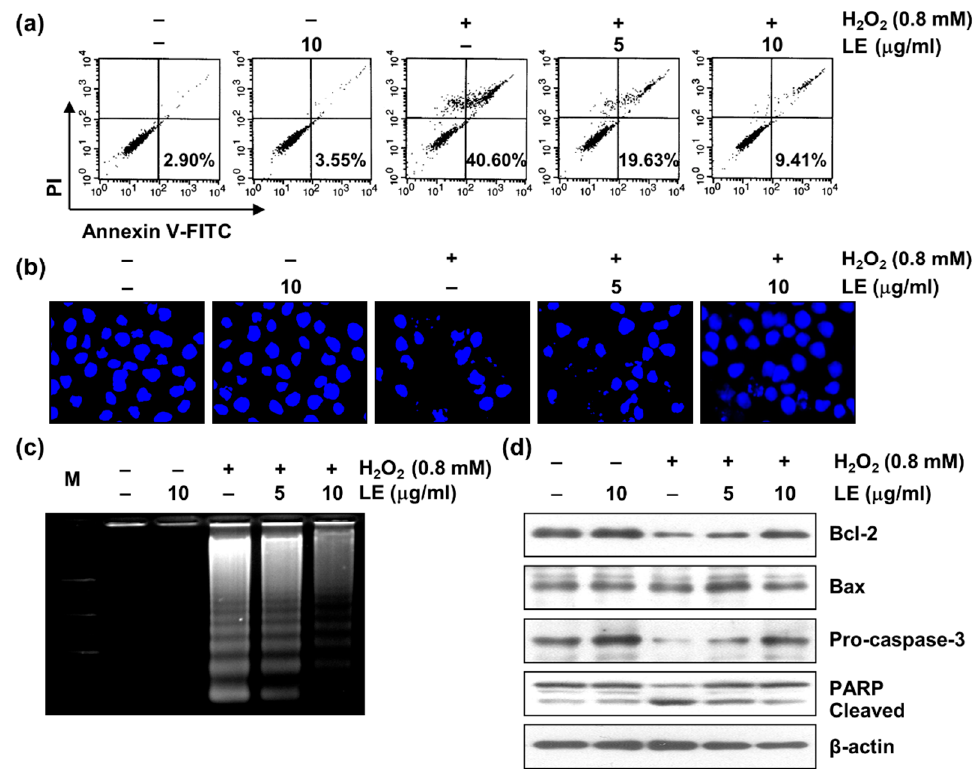
Figure 3. Effect of LE on H 2 O 2 -induced apoptosis in C2C12 cells. Cells were treated with LE for 1 h and then stimulated, with or without 0.8 mM H 2 O 2 , for 24 h: ( a ) The percentage of apoptotic cells was determined via Annexin V-FITC/PI assay. Representative results of three independent experiments are shown; ( b ) Cells were collected, fixed, and stained using 4 ′ ,6-diamidino-2-phenylindole (DAPI) solution. Stained nuclei (blue color) were observed using a fluorescence microscope. Representative results of three independent experiments are shown; ( c ) Assessment of genomic DNA fragmentation by agarose gel electrophoresis. M, Marker. Representative results of three independent experiments are shown; ( d ) Bcl-2, Bax, pro-caspase-3, and PARP levels in whole-cell lysates. Western blot analysis was performed using β -actin as a loading control. Representative results of three independent experiments are shown. Bcl-2, B-cell lymphoma 2; Bax, Bcl-2-associated X protein; PARP, poly(ADP-ribose) polymerase.